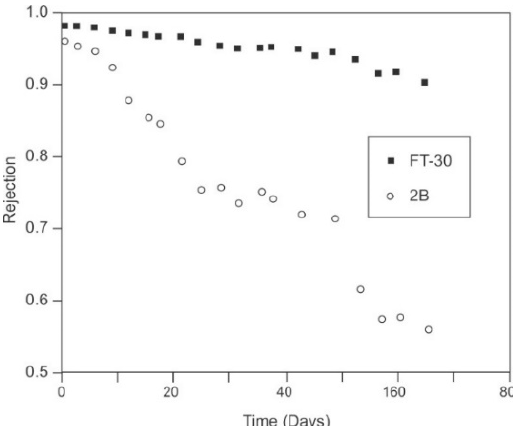
Figure 21. Rejection (reported as decimal) vs. time for DuPont-FilmTec FT-30 and Universal Oil Products UOP-L membranes. Conditions: 22 bar, pH 7.0, conductivity 6000 µS/cm with 1 ppm chlorine dioxide [342]. Reprinted with permission of Elsevier B.V.